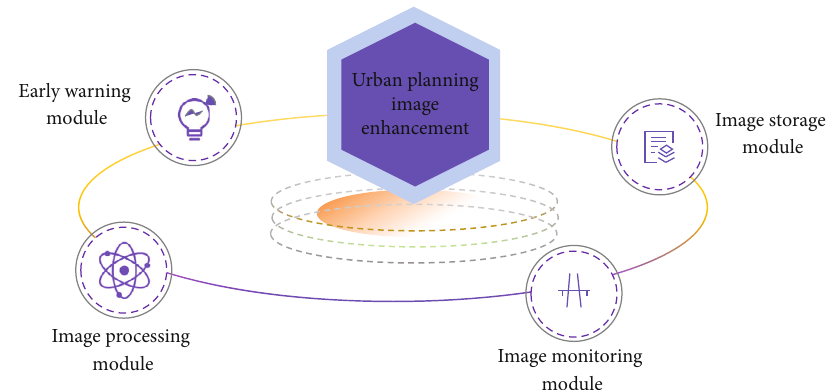
Figure 2: Composition of urban image monitoring system.